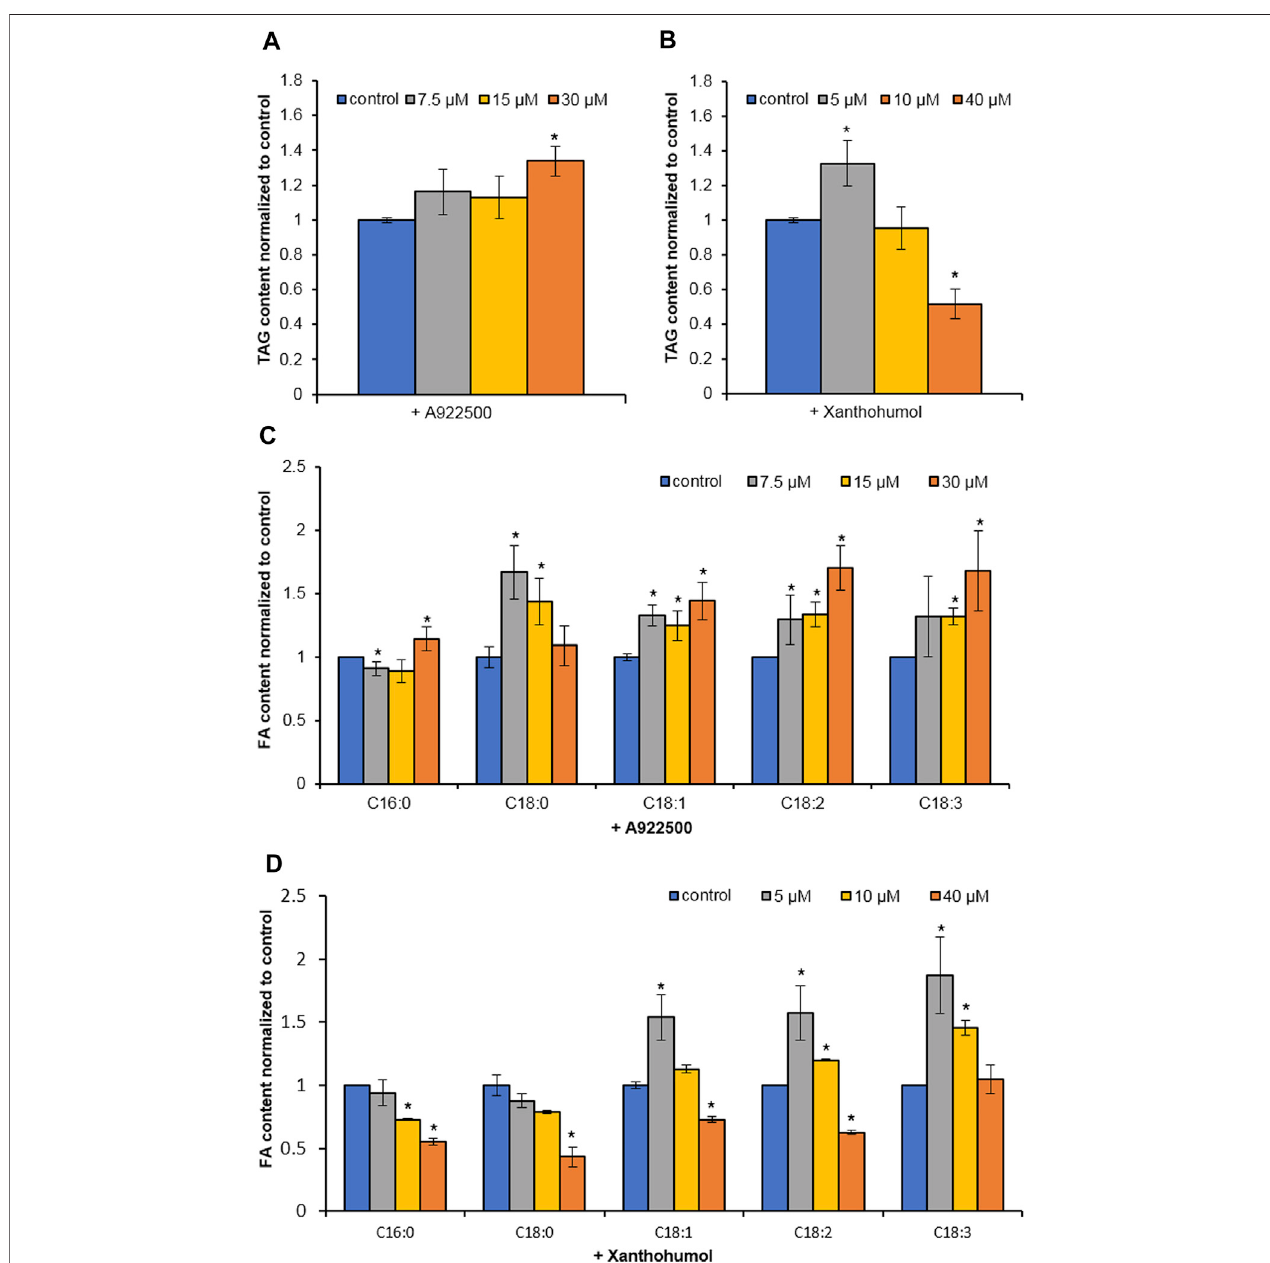
FIGURE 4 | Effect of DGAT inhibitors on TAG biosynthesis in Haematococcus pluvialis under HL stress for 24 h. (A) TAG content in H. pluvialis fed with A922500 ranged from 7.5 to 30 µM. (B) TAG content in H. pluvialis fed with xanthohumol ranged from 5 to 40 µM. (C) Fatty acid content in H. pluvialis fed with A922500 ranged from 7.5 to 30 µM. (D) Fatty acid content in H. pluvialis fed with xanthohumol ranged from 5 to 40 μ M. A922500, DGAT1-speci fi c inhibitor; xanthohumol, DGAT1, and DGAT2 inhibitor. Data are expressed as mean ± SD, n (cid:1) 3. * p < 0.05 (Student ’ s t -test).